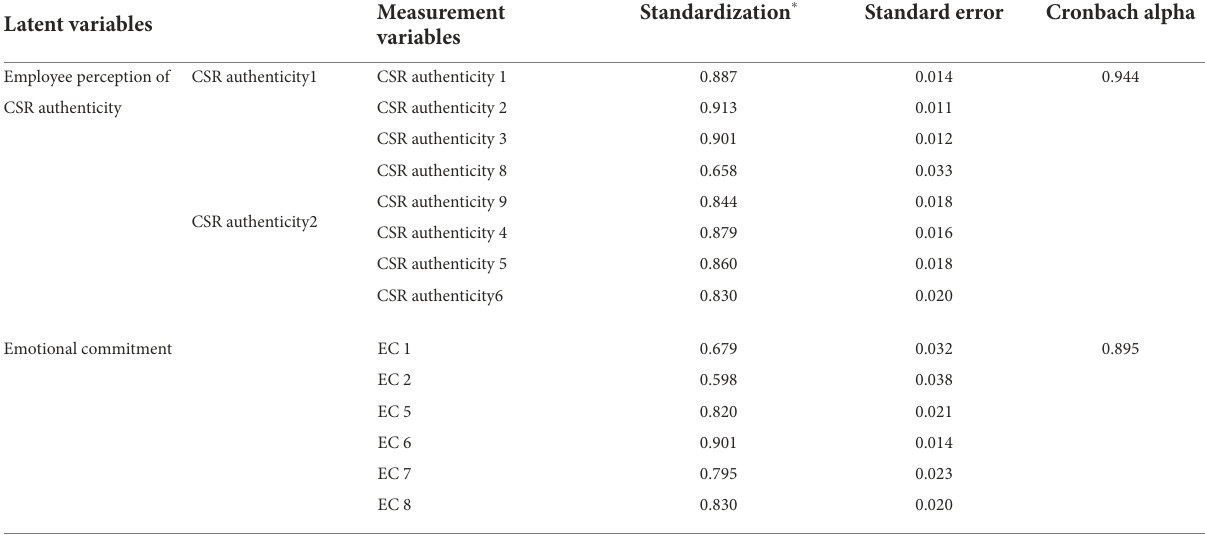
TABLE 5 Results of confirmatory factor analysis. Latent